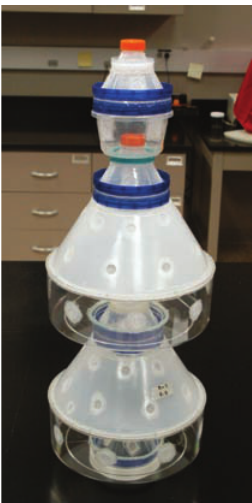
Figure 8: Larger size cage system